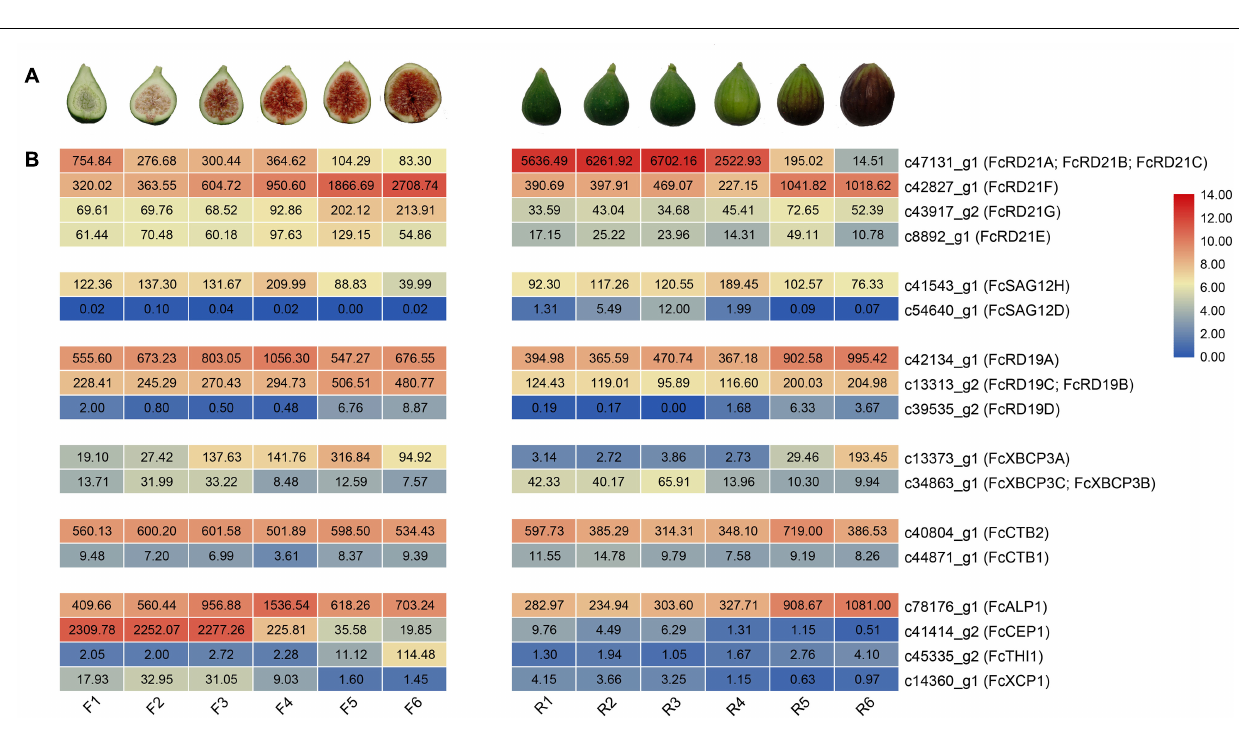
FIGURE 4 | Promoter analysis of FcPLCP s by Plant CARE, based on 2,000-bp sequence upstream of the genes. Detailed information on cis -elements is given in Supplementary Table 4 .